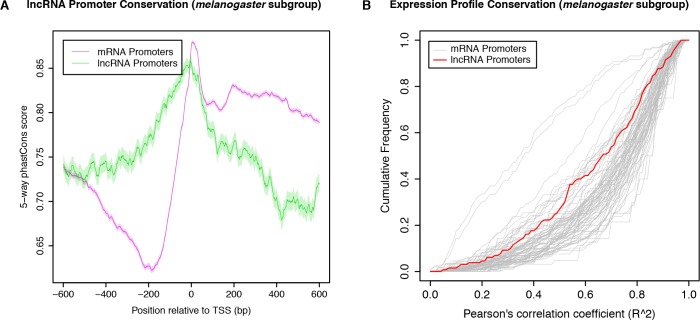
Conservation of melanogaster subgroup lncRNA TSCs.(A) Promoter sequence conservation. melanogaster subgroup-specific phastCons scores over lncRNA or protein-coding gene promoters that are shared across the three species of the subgroup. These phastCons scores were computed by including exclusively the genomes of the five sequenced melanogaster subgroup species in the input multiple sequence alignment. (B) Expression specificity conservation. All functionally shared promoters with maximum 25 RPM and 5-fold expression changes in D. melanogaster were included in the analysis (130 lncRNA promoters).